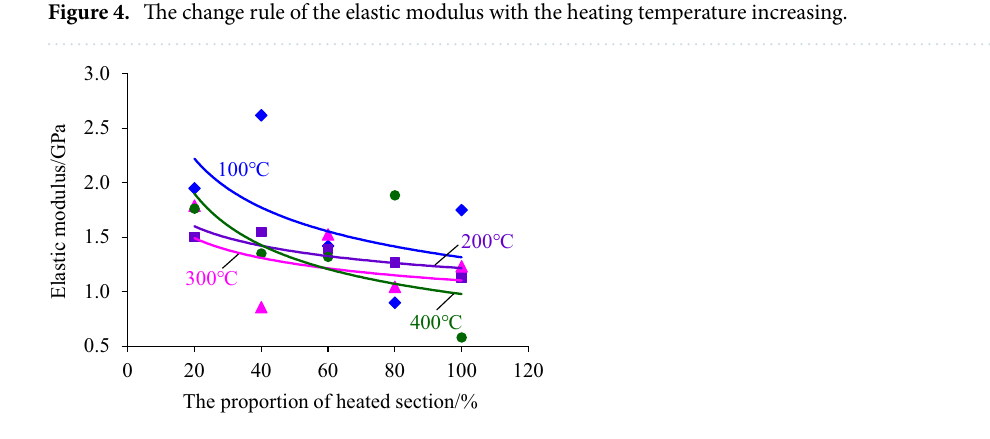
Figure 5. The change rule of the elastic modulus with the increase of the heating segment